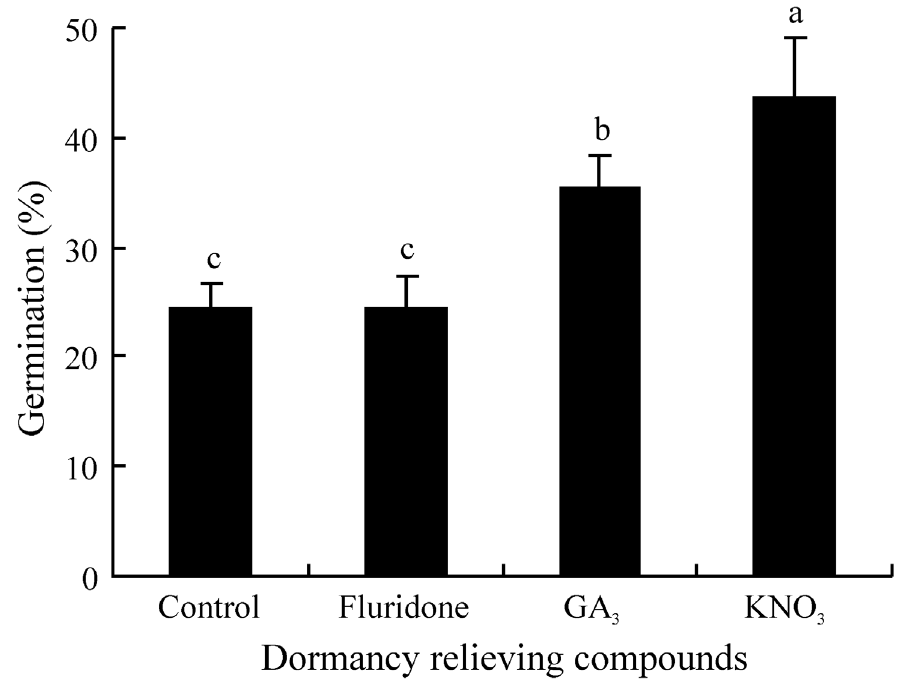
Figure 4. Effect of fluridone, GA 3 and KNO 3 on germination of fresh seeds of Stipabungeana in dark at 20 u C. Different letters indicate significant difference (P , 0.05) among all treatments (n=4).